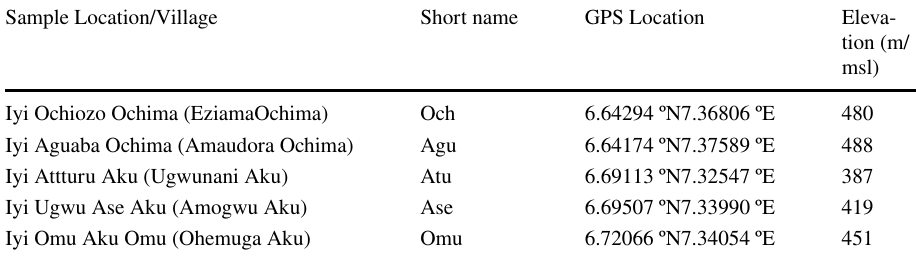
Table 1 GPS Location of the Sampling Sites